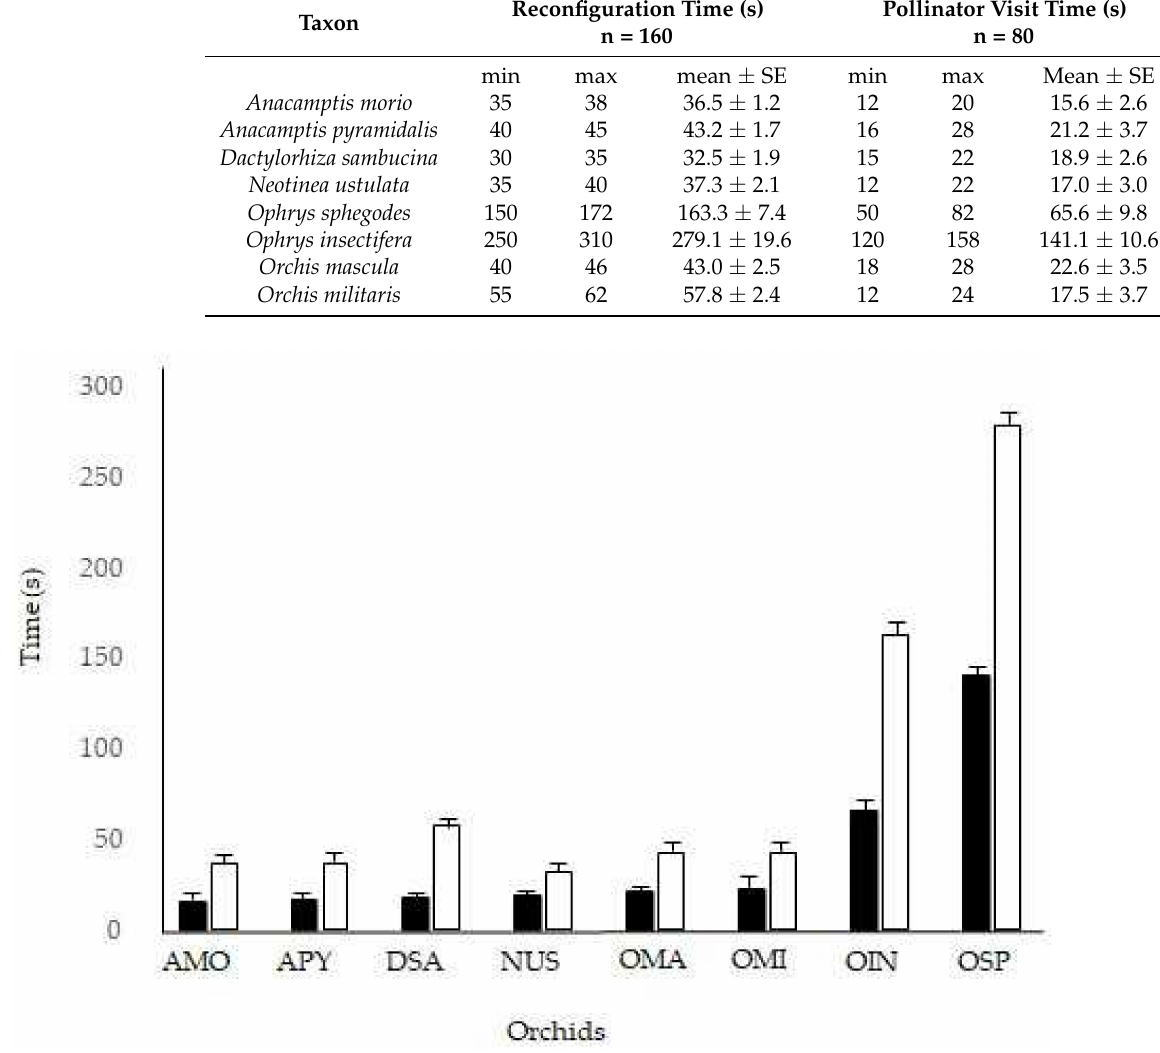
Figure 3. Pollinator residency time (black bars) and pollinaria reconfiguration time (white bars) of examined orchids in the field. AMO = Anacamptis morio , APY = A. pyramidalis , DSA = Dactylorhiza sam- bucina , NUS = Neotinea ustulata , OMA = Orchis mascula , OMI = Orchis militaris, OIN = Ophrys insectifera , OSP = O. sphegodes